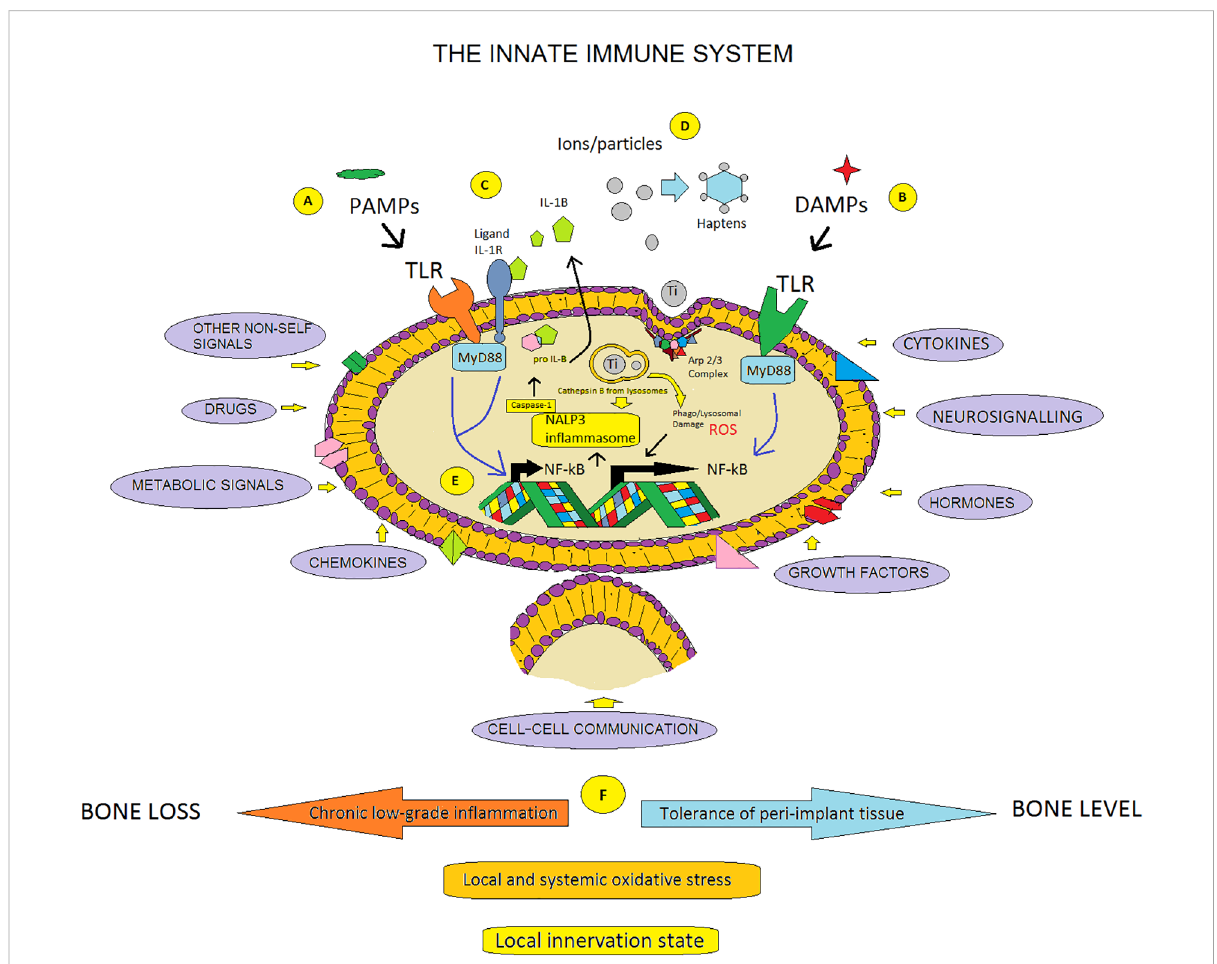
FIGURE 6 Common molecular pathways and environmental signals. (A, B) Toll-like receptors (TLRs) and other types of pattern recognition receptors recognize PAMPs and DAMPs and trigger in fl ammation via the activation of the transcription factor NF-Kb. Signaling pathway that requires the adaptor molecule MyD88. (C) In addition, in fl ammation in response to necrotic cells is mostly mediated by IL-1 receptor (IL-1R), which leads to NF-kB activation. (D) On the other hand, titanium particles can induce acute in fl ammation due to activation of the NALP3 in fl ammasome, which leads to increased IL-1 secretion and IL-1-associated signaling. Process mediated by protein complexes such as the Arp 2/3 complex. Also, titanium ions can bind to proteins, such as albumin or transferrin, creating a bioavailable metalloprotein that could serve as an antigen in immunological reactions. (E) Activation of NF- k B , the master in fl ammatory transcription factor. (F) Macrophages and other cells of the innate immune system respond to a large number of signals emanating from their local environment, therefore, the in fl ammatory potential can be multiplied due to the synergistic activation of pro-in fl ammatory pathways. In this sense, it is known that the crosstalk between the skeletal system and the immune system can lead to osteoclastogenesis, for example, through IL-1. A speci fi c biologic response of either in fl ammation or tolerance in a particular patient could be related to local and systemic oxidative stress, and other basal states, such as the state of local innervation. All these possible cellular and molecular mechanisms would be constantly counteracted/balanced by both the